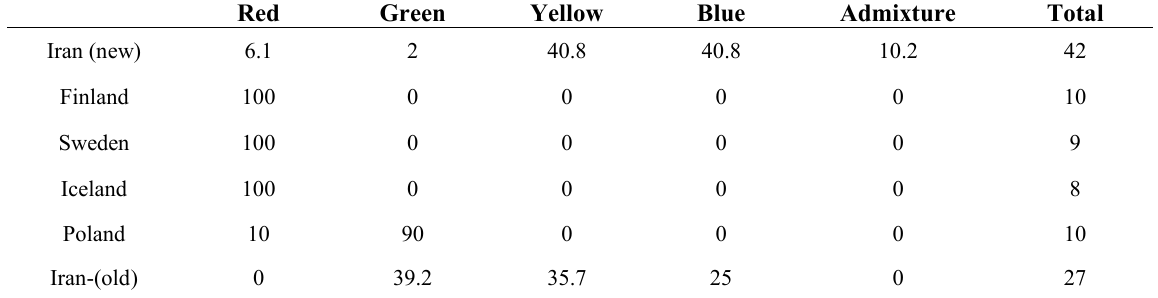
Table 5. The proportion membership of each individual of the six populations in each of the 4 gene pools identified by Structure